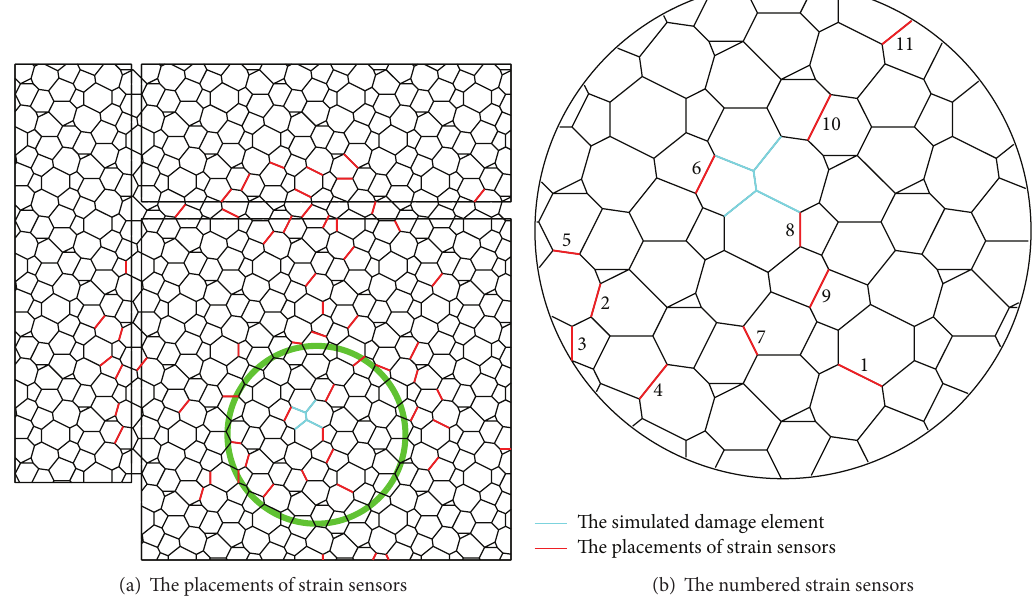
Figure 9: The previous placements of strain sensors. Table 4: The MAC values of damage parameter induced by strain sensors.